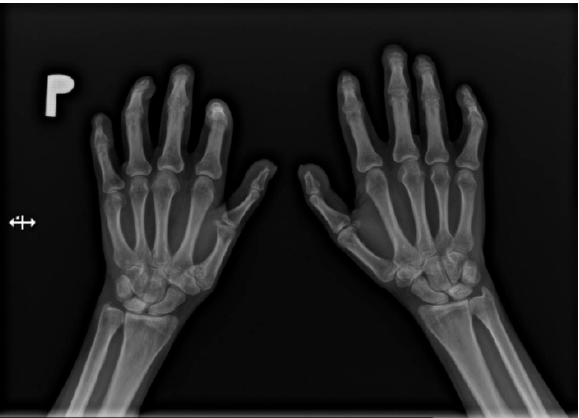
Figure 2. A ‐ P view of the hand radiograph in a patient with systemic sclerosis shows acro ‐ osteolysis of the distal phalanx of the first, second, third, and fourth fingers of both hands. Additionally, small joint contractures and areas of calcinosis in the fingertips are visible.